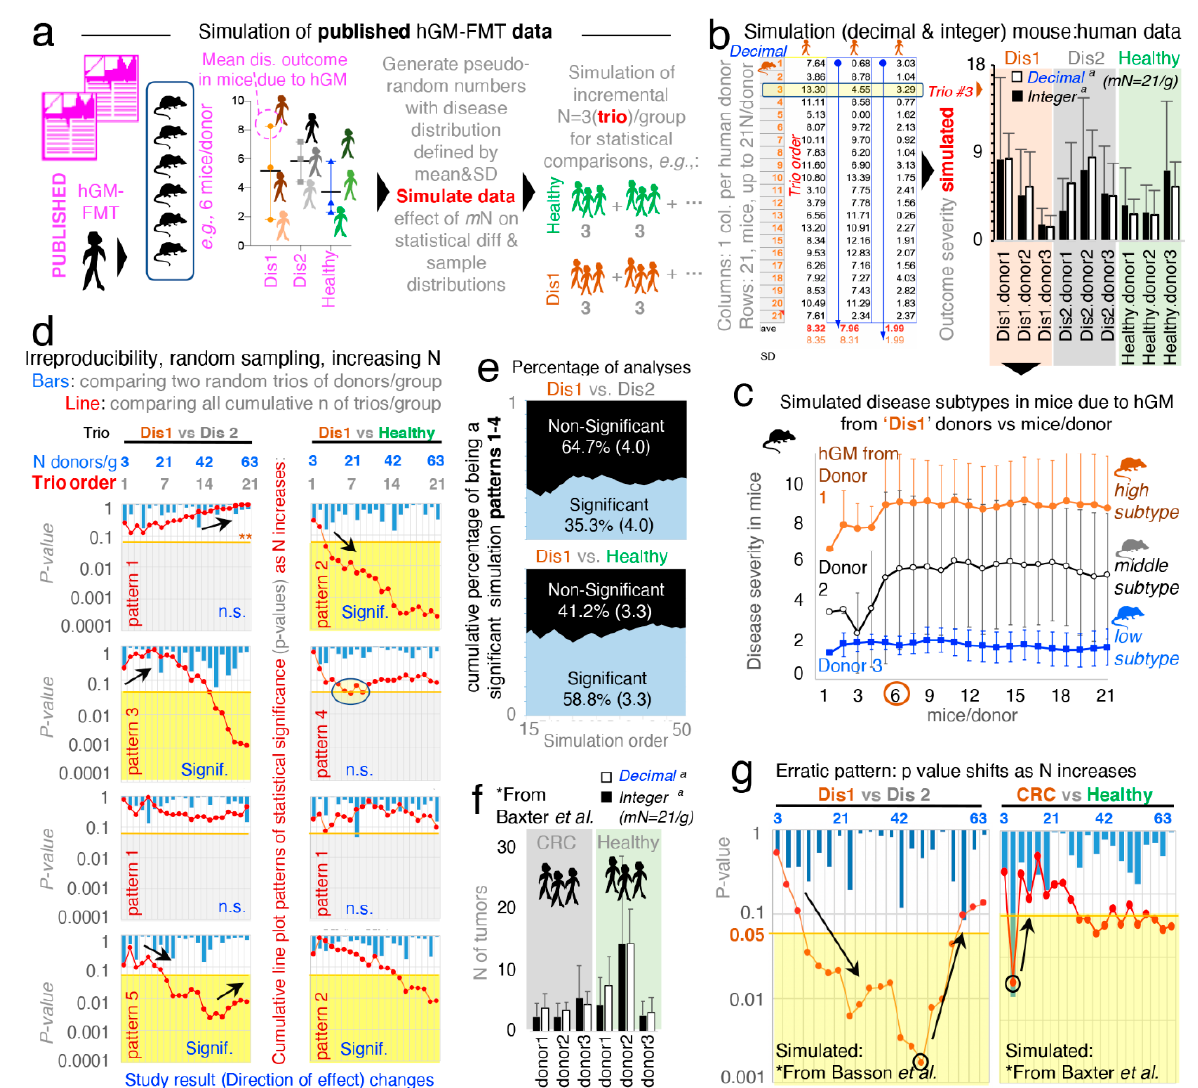
Figure 1. Random sampling from overlapping datasets yield unexpected “linear patterns of cumulative statistical irrepro- ducibility”. Simulations on observed data from Basson et al. [52] to visualize disease vs. healthy datasets. ( a ) Method overview to generate pseudorandom numbers and simulations from published (observed) data (see details/formulas in Supplementary File 1 and Supplementary Figure S1). ( b ) Visualization of simulated outcomes using random decimal and integer numbers datasets generated based on 3 donors/group for Disease 1 (“Dis1”), Disease 2 (“Dis2”), and “Healthy” groups. Bar plot of N = 21 mice/donor, notice no differences between integer and decimal datasets group pattern, or abso- lute differences, superscript letter “a”, paired-t p > 0.05. ( c ) Simulation of human gut/fecal microbiota transplantations (hGM-FMT) mice data yields reproducible simulated “disease data subtypes” from 6 mice/group. ( d ) Cumulative line plots depicting patterns of statistical irreproducibility and pairwise statistical directions of effect estimates (n.s.:signif., signif.:signif., signif.:n.s., and n.s:n.s.). Representative simulations comparing two groups of donors, with N ranging from three (trio) donors/group to 63, in multiples of three (cumulative addition of new trios per group). Note Y -axis, p -value of differences using two-group Student’s t -test. Notice as N increases, the cumulative significance (red line) exhibit different linear patterns due to variance introduced by random sampling. ( e ) Percentage of simulated analysis with significant or nonsignificant pairwise difference (blue; significant, black; non-significant; and parentheses, SD). Comparison deemed significant, if at least one p -value < 0.05 across simulations with N between 3 and 63 donors/group. ( f ) Visualization of simulated outcome using observed data from Baxter et al . [21]. No differences between integer and decimal datasets, superscript letter “a”, paired-t p > 0.05. ( g ) Random simulations illustrate “erratic” statistical patterns. Notice as N in- creases, group differences become more significant, until an inflection point, where adding more donors makes the signif- icance disappear. See Supplementary Figure S2 for additional examples and computed R 2 value to illustrate the linearity of the correlation between N and statistical significance.